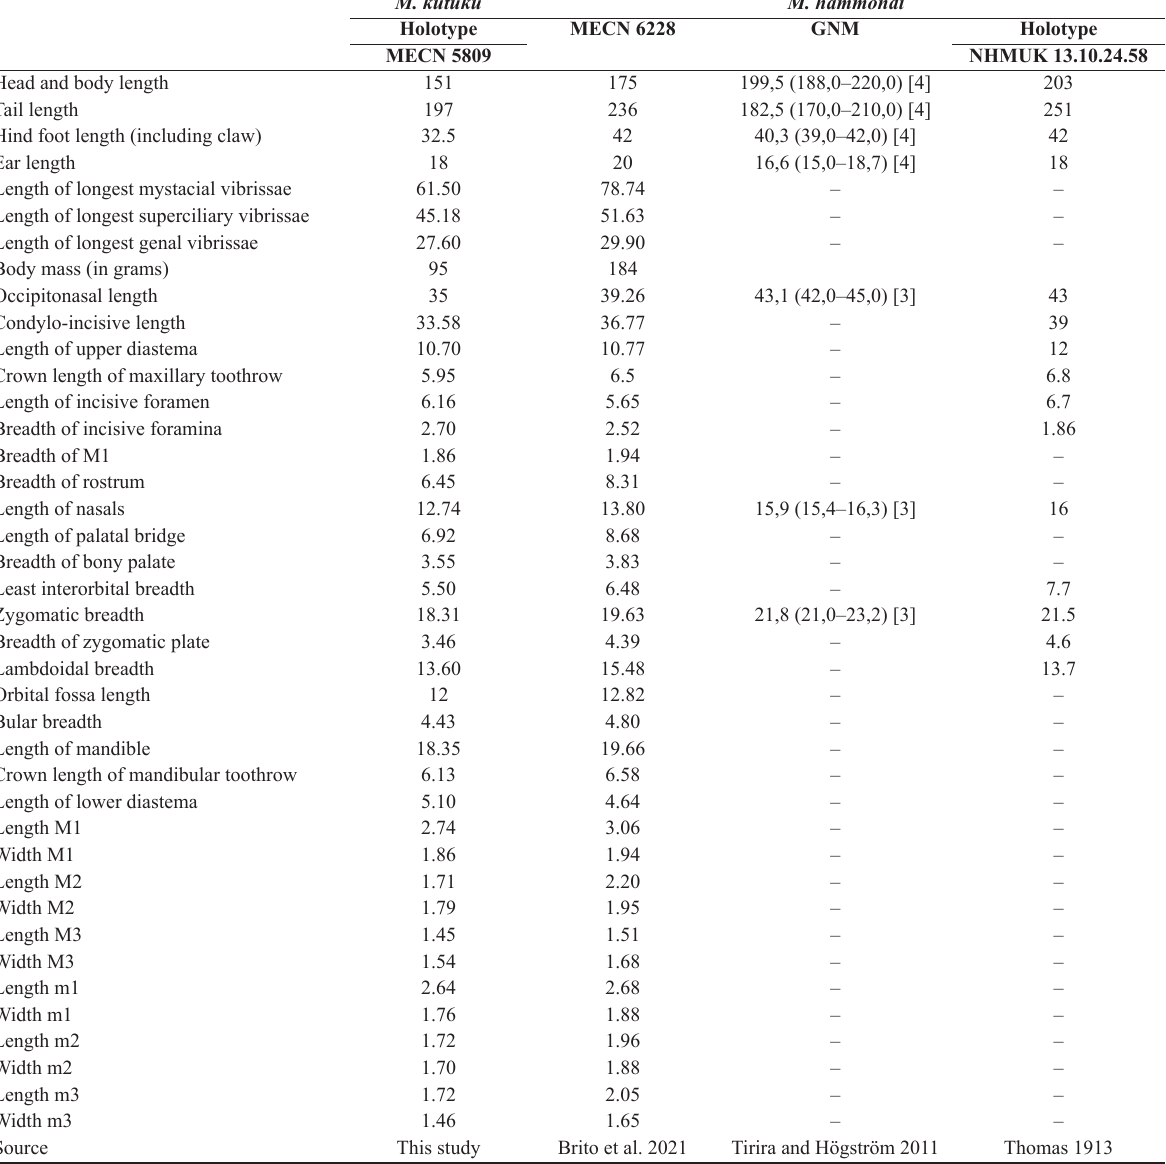
Table 3. External and skull measurements (in